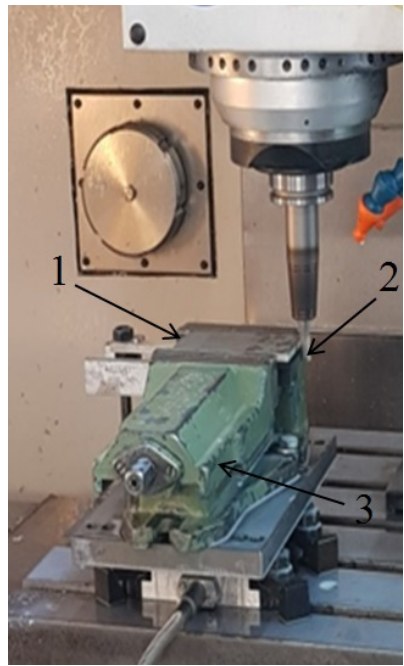
Figure 3. Milling of a sandwich structure: 1. sample, 2. tool, 3. machine vice.